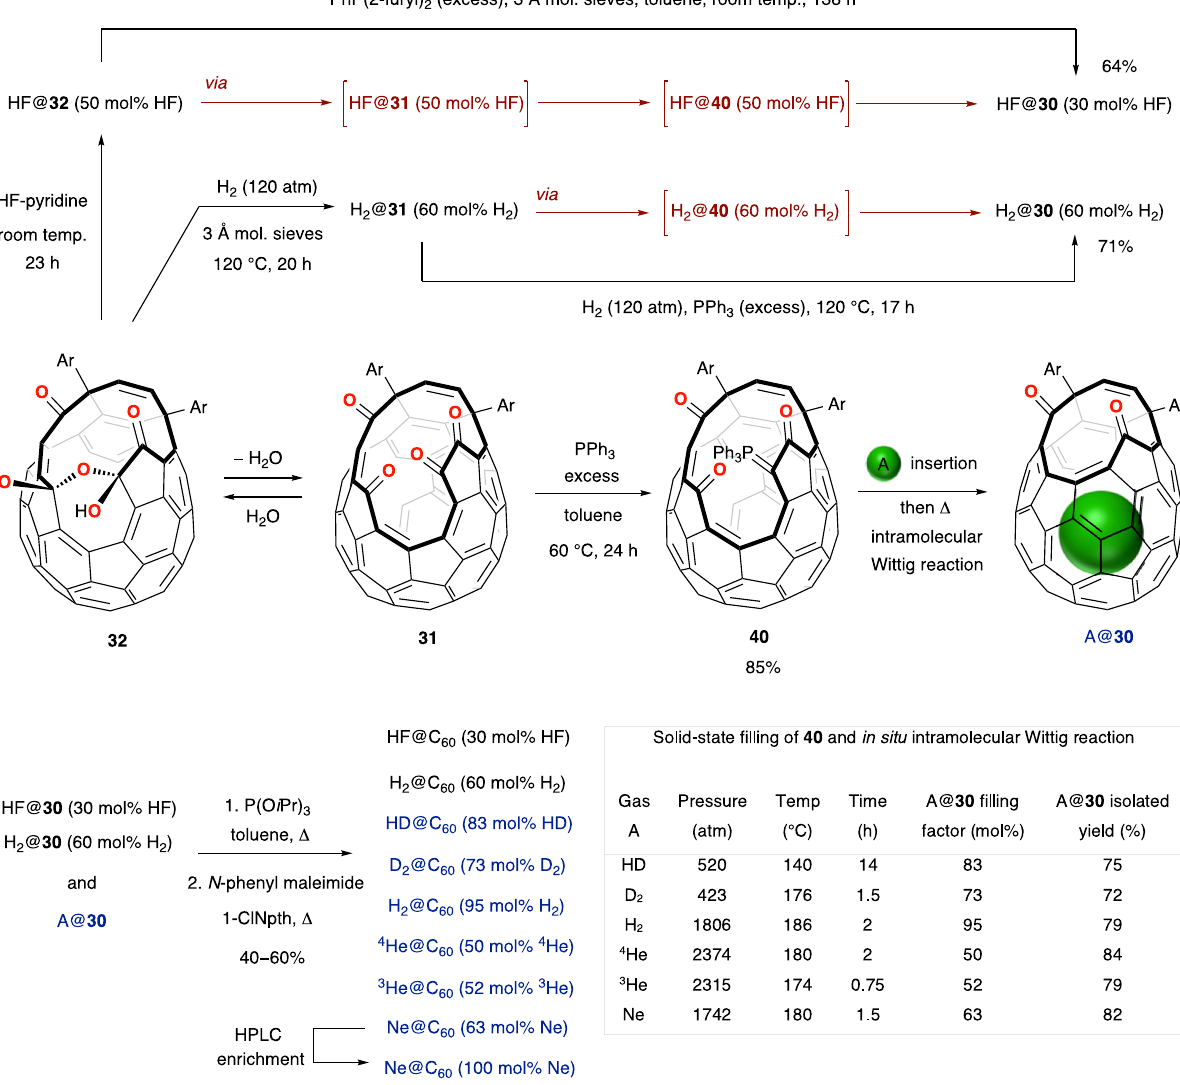
Fig. 6 Whitby ’ s synthesis of closed C 60 endofullerenes containing a small endohedral species. Open-cage fullerenes 31 and 40 each have a 16- membered ori fi ce able to accommodate the entry of guest species. Solution-phase encapsulation of H 2 or HF by 31 occurs via dehydration of bis(hemiketal) 32 for synthesis of H 2 @C 60 and HF@C 60 . Solid-state fi lling of 40 was performed under the tabulated conditions for optimised synthesis of H 2 @C 60 and He@C 60 isotopologues, and Ne@C 60 . High-pressure solid-state fi lling was carried out in a 100 × 5.2 mm 316 L stainless steel reactor as part of a